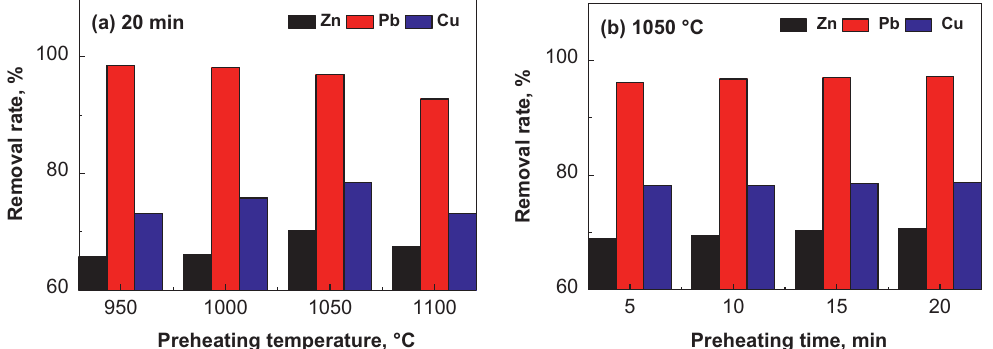
Figure 4: Effects of preheating on removal of Zn, Pb and